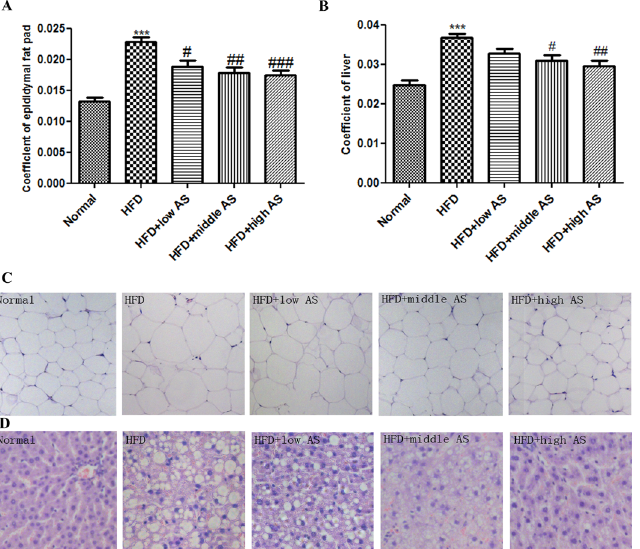
Fig 2. AS extract reduces adipose tissue weight, white adipocyte size and liver accumulation in obese rats. Coefficients of ( A ) epididymal adipose tissue and ( B ) liver were calculated after rats had fasted for 12 h at the end of experiment according to the following equation: coefficient = tissue (g/rat)/weight (g/rat). ( C ) Epididymal adipose tissue and ( D ) liver were stained with hematoxylin and eosin for histopathological examination. Images were acquired at 400× magnification on a light microscopy. Values are expressed as mean ± SE (n = 6). Significant differences were observed between normal and HFD groups. * P < 0.05, ** P < 0.01, *** P < 0.001 vs. normal group; # P < 0.05, ## P < 0.01, ### P < 0.001 vs. model group.